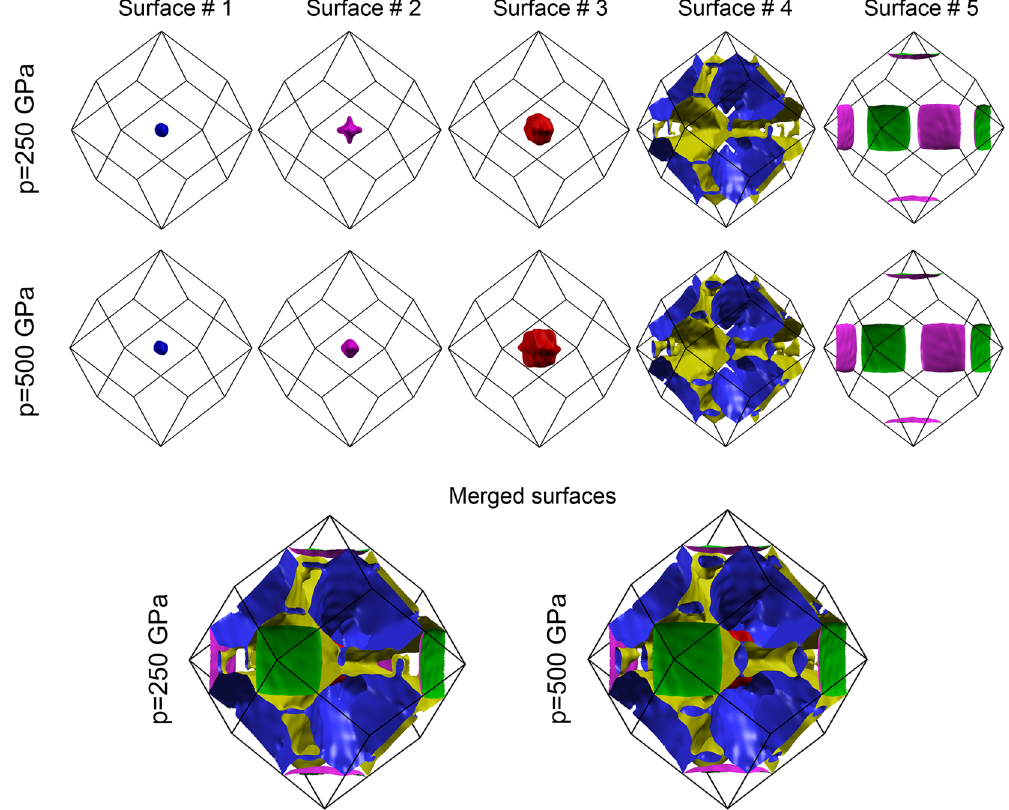
Figure 3. The Fermi surface of the Im m 3 structure of H 3 S at 250 and 500 GPa. (Top) The Fermi surface is formed by 5 different surfaces crossing the Fermi energy. (Bottom) The view of the merged Fermi surfaces at 250 and 500 GPa including all the surfaces.